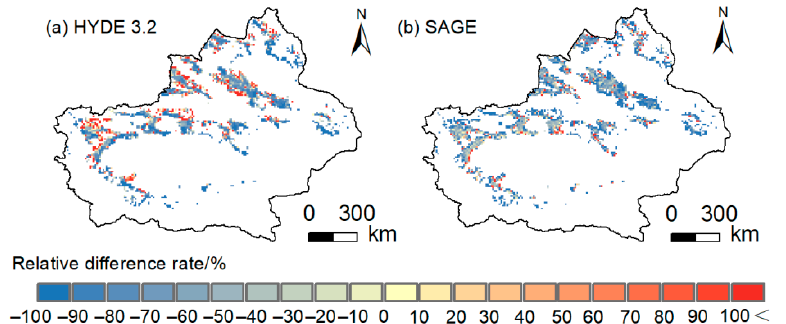
Figure 6. Spatial distributions of the relative difference rate for cropland in Xinjiang province be- tween CWLUCC and the HYDE 3.2 and SAGE datasets for AD 2000.